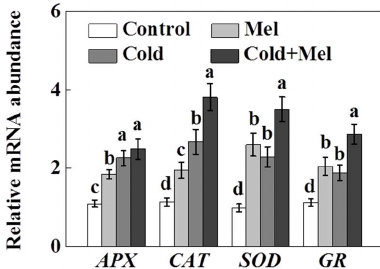
Figure 5. Effect of melatonin application on the transcripts of genes for ascorbate peroxide (APX), superoxide dismutase (SOD), catalase (CAT), and glutathione reductase (GR) in tea leaves in the presence or absence of cold stress treatment. Mel, melatonin. Each data point presents the mean of six replicates ( ± S.D. (standard deviation)). Means denoted by different letters are significantly different ( p < 0.05) based on the Tukey’s